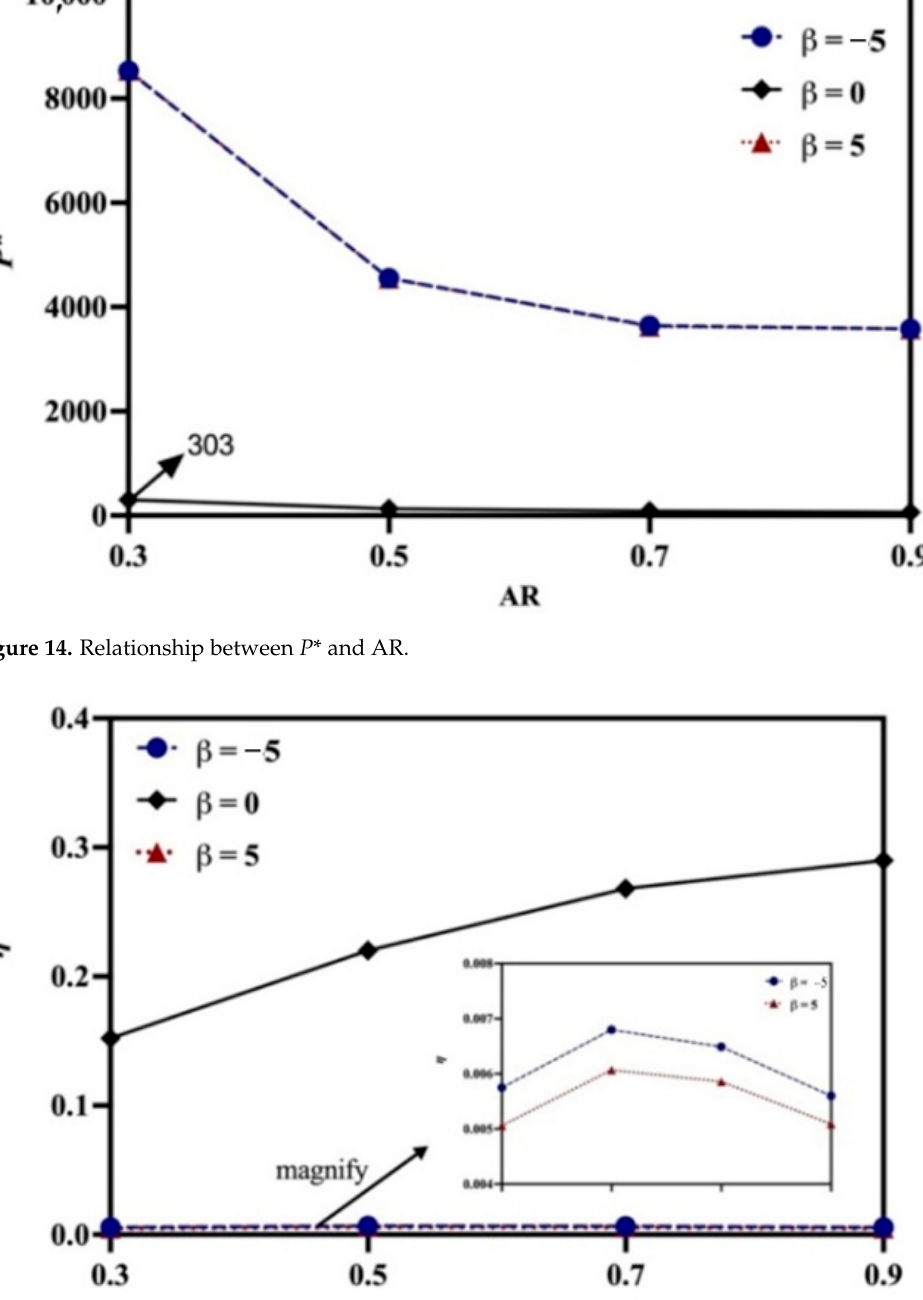
Figure 13. Relationship between u * and AR.